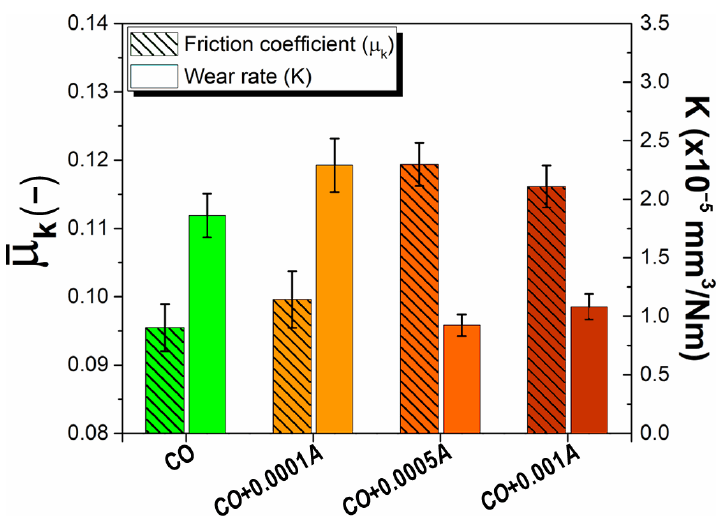
Figure 12. Effect of different concentrations of Astaxanthin as an additive in CO on the friction (µ k ) and wear (K) response.